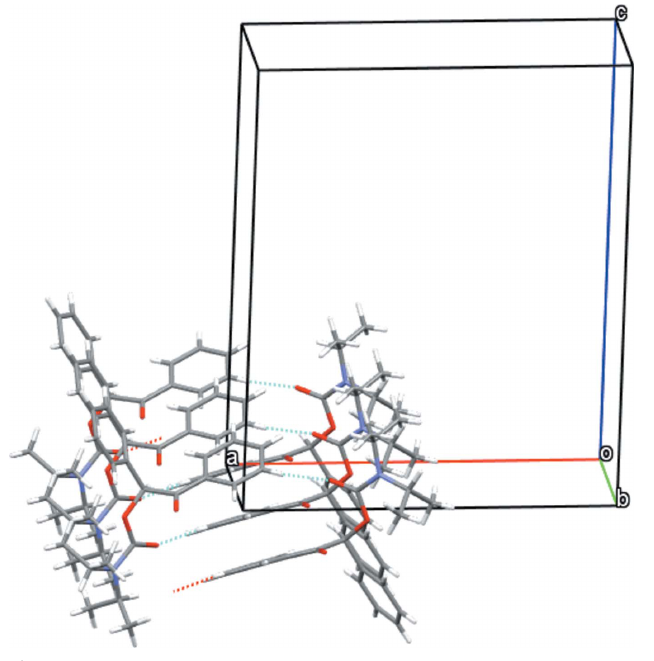
Figure 2 Crystal structure of the S -enantiomer of the title compound showing the helical arrangement of molecules parallel to the b axis built up by C— H (cid:2)(cid:2)(cid:2) O hydrogen bonds.